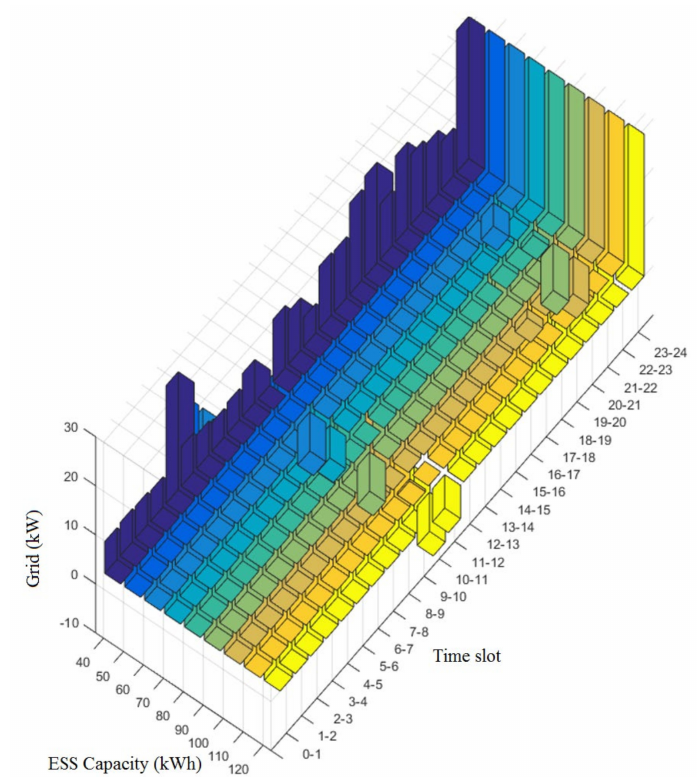
Figure 10. System power usage by ESS capacity (3).